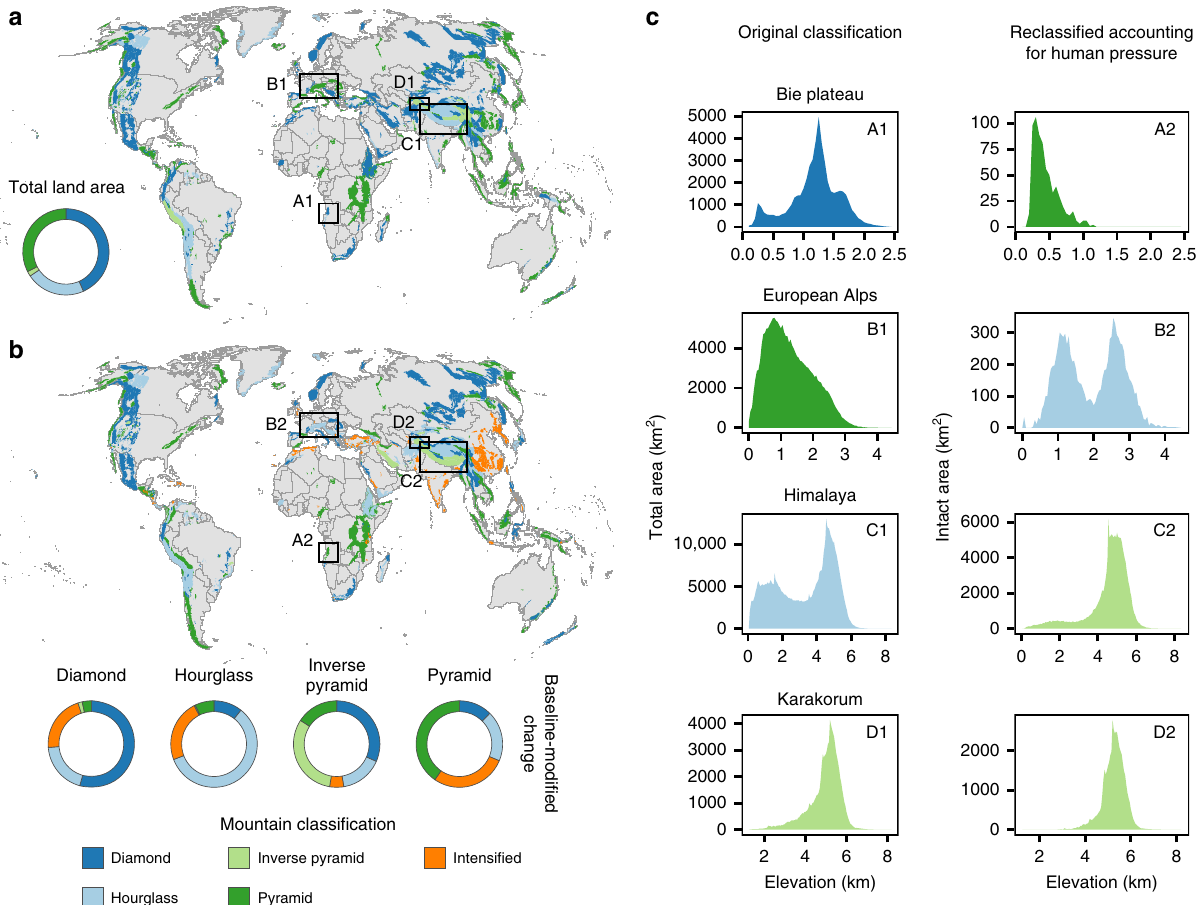
Fig. 1 The global distribution of topographic classes within mountain ranges. The distribution of classes when considering all land a and intact land b . Inset donut plot in a shows the proportion of mountain ranges per mountain class considering total land area. Inset donut plots in b show the proportion of ranges from their original classi fi cation in each mountain class (denoted by donut labels) that were then reclassi fi ed considering only intact land area. Mountain ranges classi fi ed as intensi fi ed have no intact land area remaining when removing all land under intense human pressure. c Comparisons of area- elevation distributions considering total land area (left column) and intact land area (right column) for four example mountain ranges, colored by mountain classi fi cation. Black rectangles with alphanumeric symbols in a and b indicate the geographical location of each mountain range in c